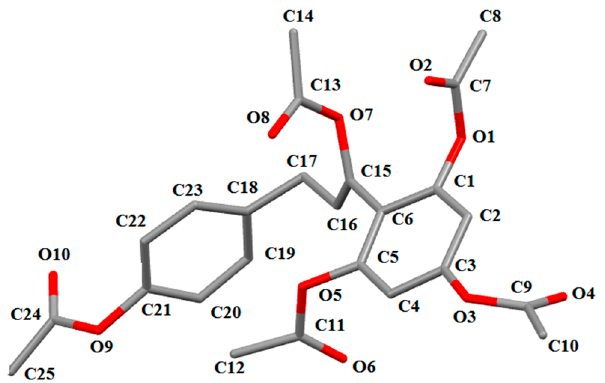
Figure 3. The molecular structure of 8 , showing the atom numbering scheme. For the sake of clarity, H atoms have been omitted. Displacement ellipsoids are drawn at the 30% probability level.